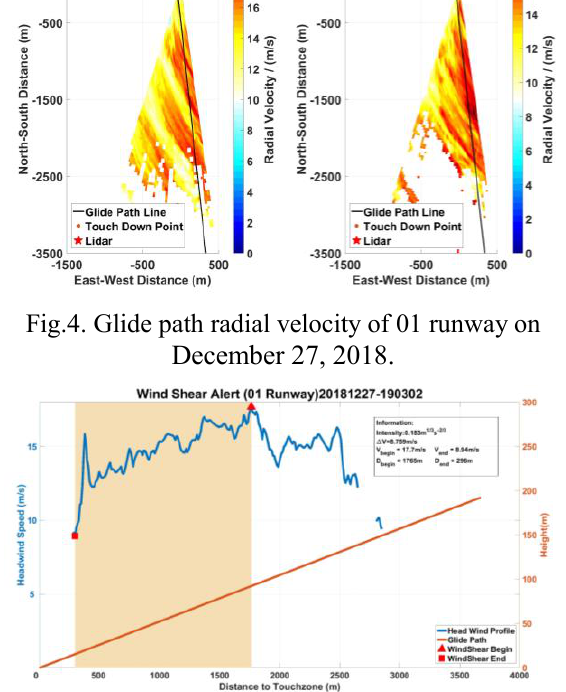
Fig.5. Headwind profile of 01 runway on December 27, 2018.